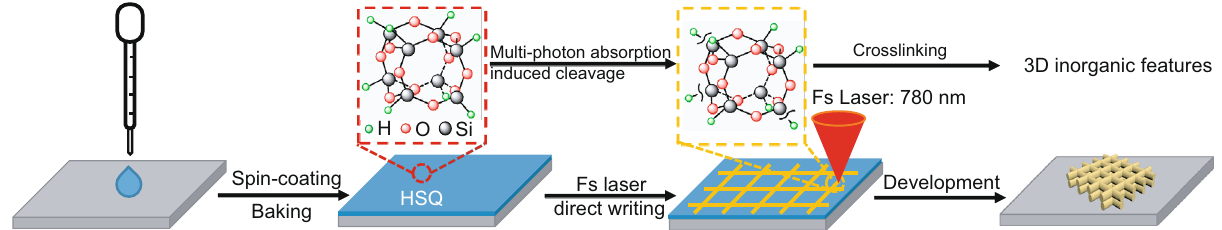
Fig. 1 Multi-photon 3D lithography of inorganic features. Schematic of the fabrication of 3D nanoscale inorganic features by femtosecond laser direct writing of